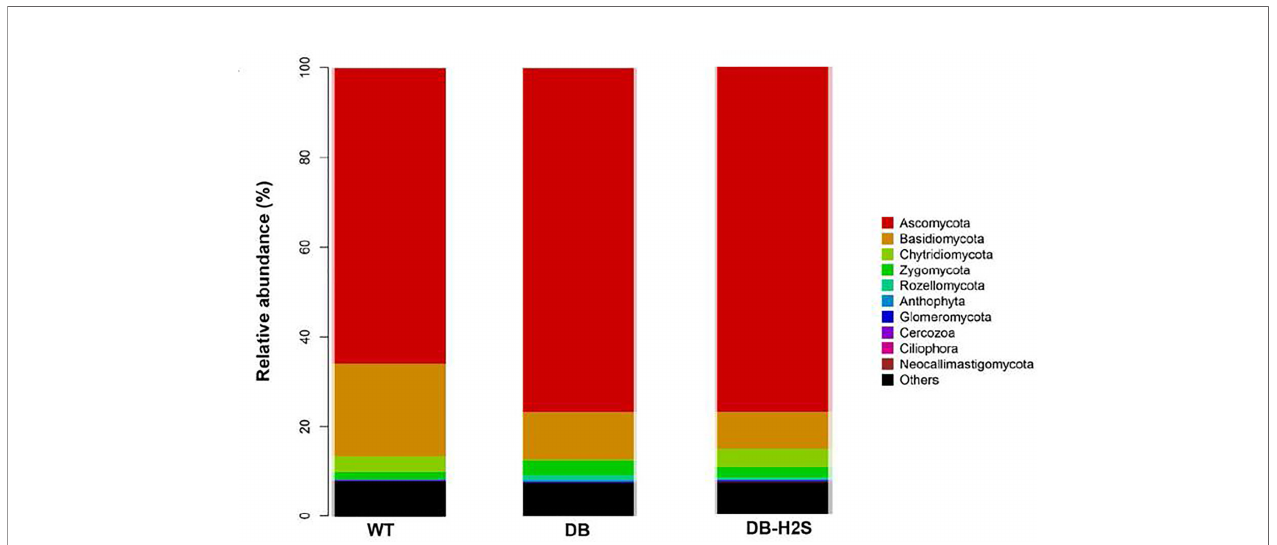
FIGURE 6 | Effect of exogenous H 2 S on the gut mycobiome composition. Changes in the fungal taxonomic composition of the gut microbiota at the phylum level. WT, wild-type mouse group (n = 6); DB, db/db mouse group (n = 6); DB-H 2 S, db/db mouse treated with NaHS group (n = 6).